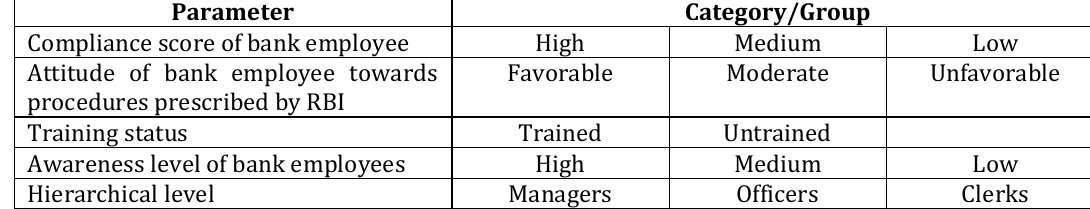
Table 3: Classification of Respondents into Categories based on Parameters